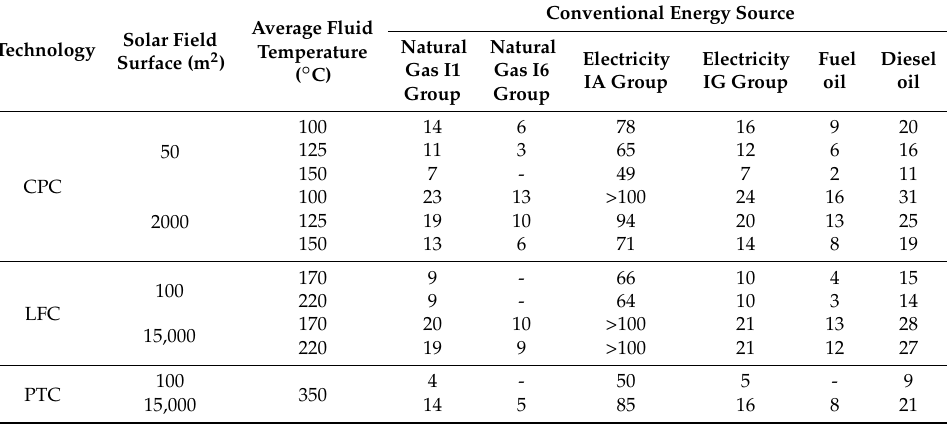
Table 25. Internal Rate of Return.